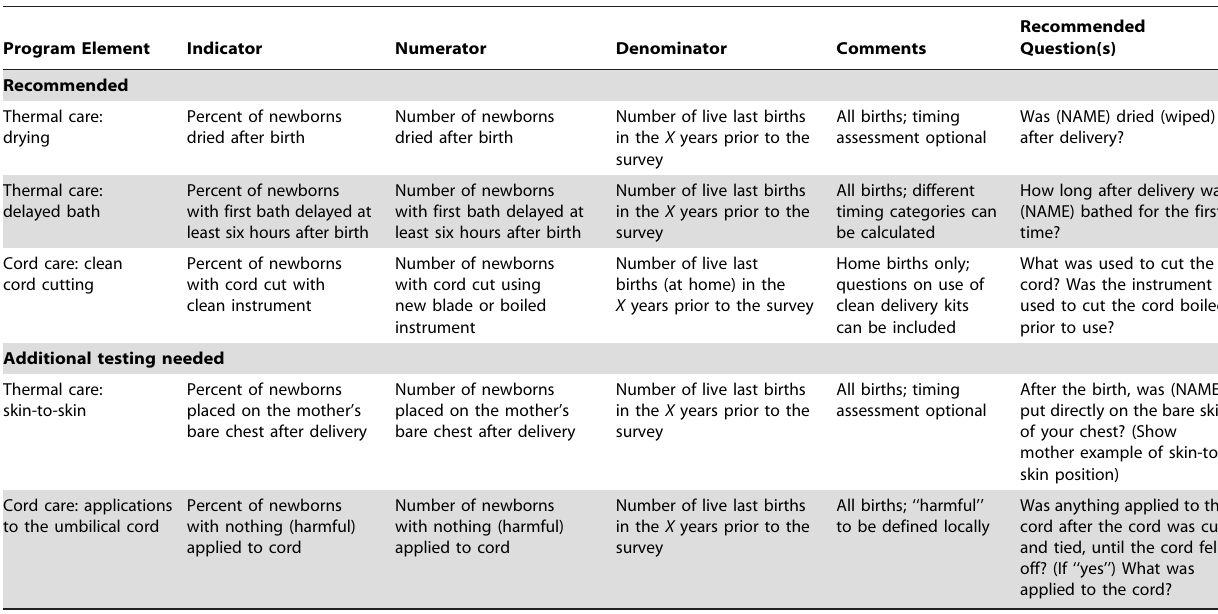
Table 3. Recommended indicators for care behaviors and practices for